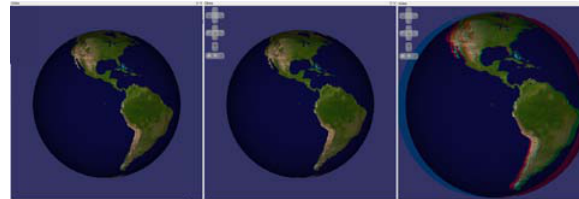
Figure 7. Evolution of the Globe Plug-in. Basic globe, globe with GUI, globe with GUI and stereo 3D